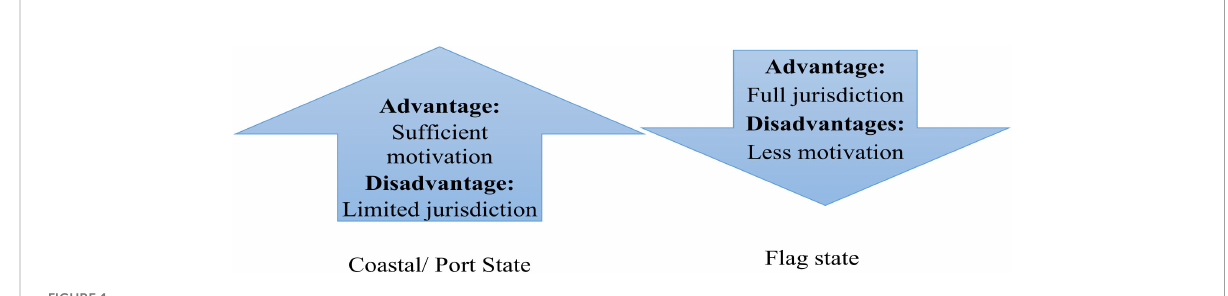
FIGURE 1 Regulating Marine Pollution Based on Different